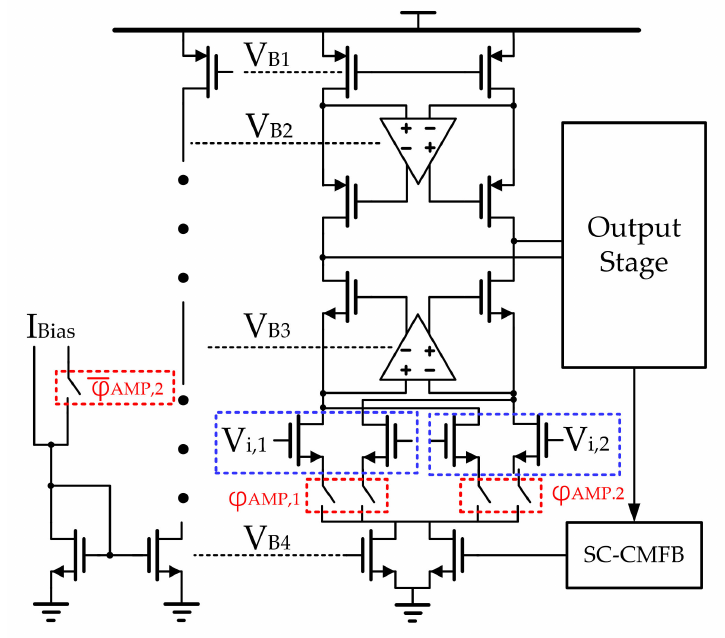
Figure 11. The shared op-amp with adjustable bias. The two input pairs for different inputs are in the blue dashed box, along with their control switches in the red box. When operating for the 2nd stage, the switch on I Bias ( left ) is open, reducing the overall bias current and saving